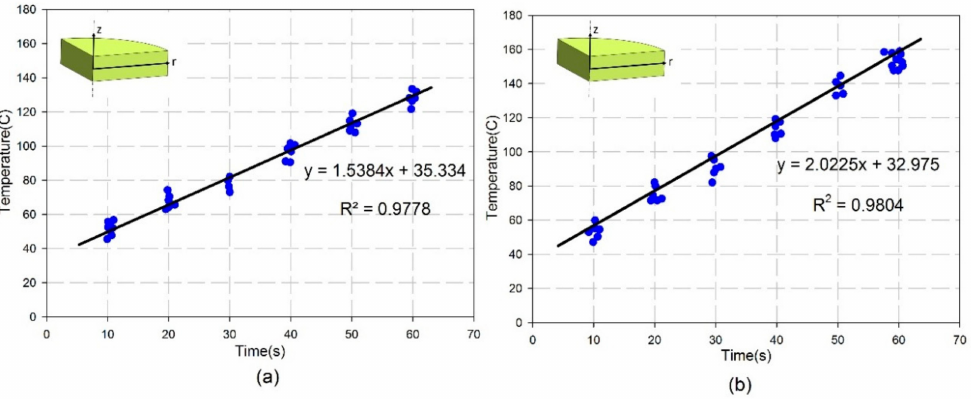
Figure 8. The temperature profile comparison between experiment and simulation; ( a ) unripe bananas; ( b ) ripe